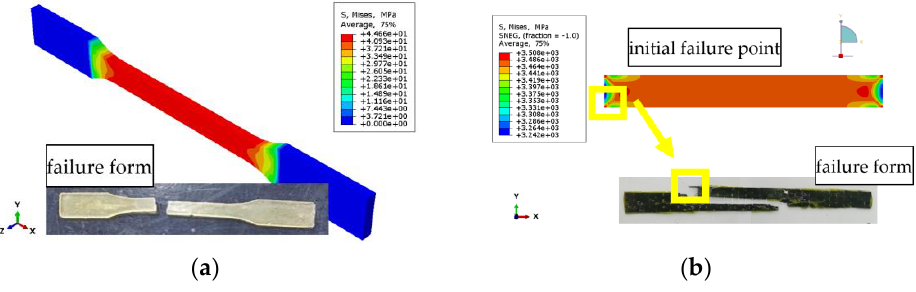
Figure 33. Stress nephogram: ( a ) Epoxy resin; ( b ) CFRP sheet.